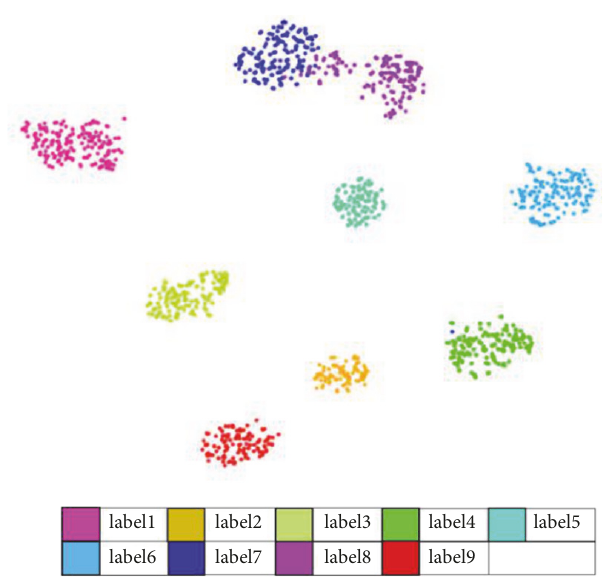
Figure 7: Two-dimensional scatter plot of high-dimensional fea- tures generated with